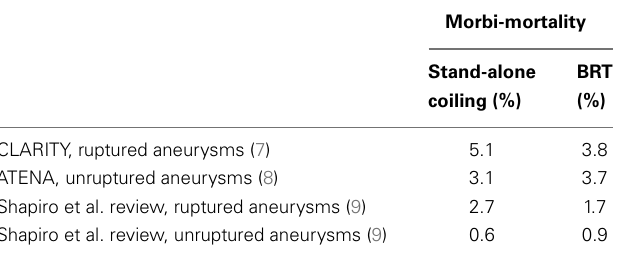
Table 1 | Balloon remodeling technique and complications with clinical